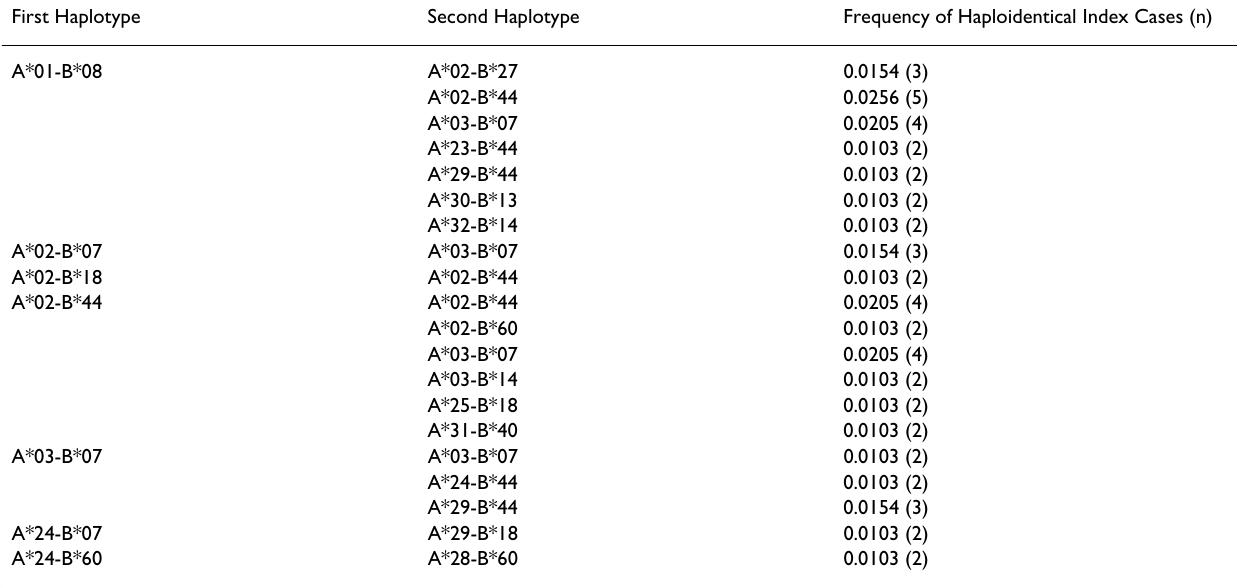
Table 5: HLA Haploidentical Alabama Index Cases. 1 First